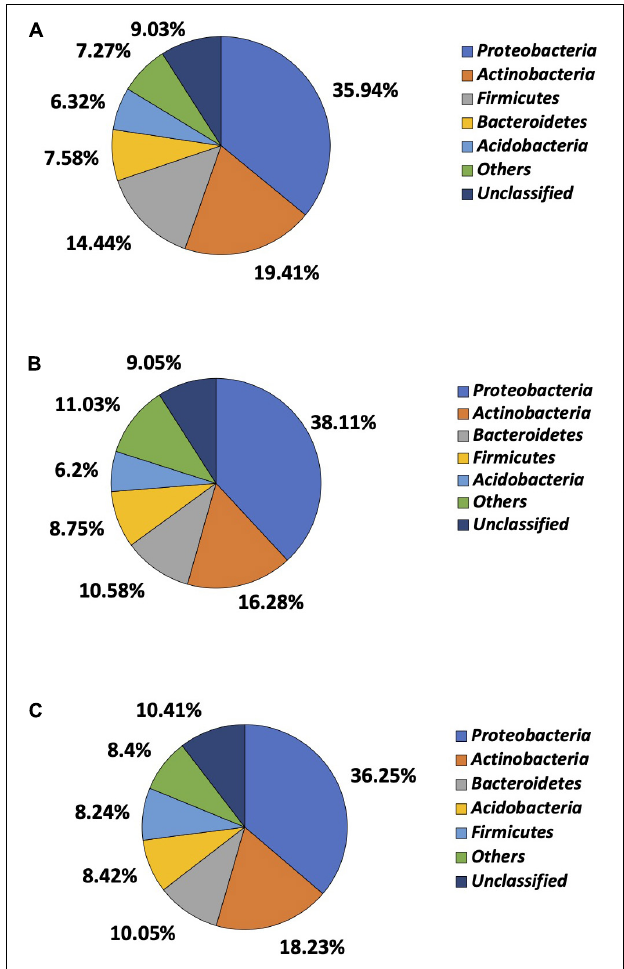
FIGURE 4 | Microbial composition determined at phylum level by 16S rRNA sequencing. (A) Phylum distribution of soil bacteria in Garden E. (B) Phylum distribution of soil bacteria in Garden G. (C) Phylum distribution of soil bacteria in Garden O.